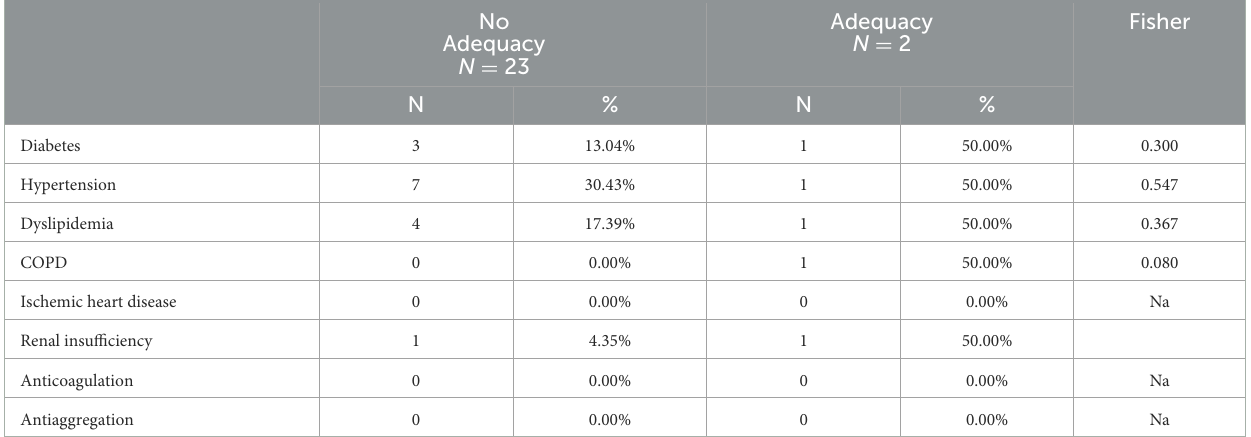
TABLE 4 Adequate vs. inadequate transfusion and